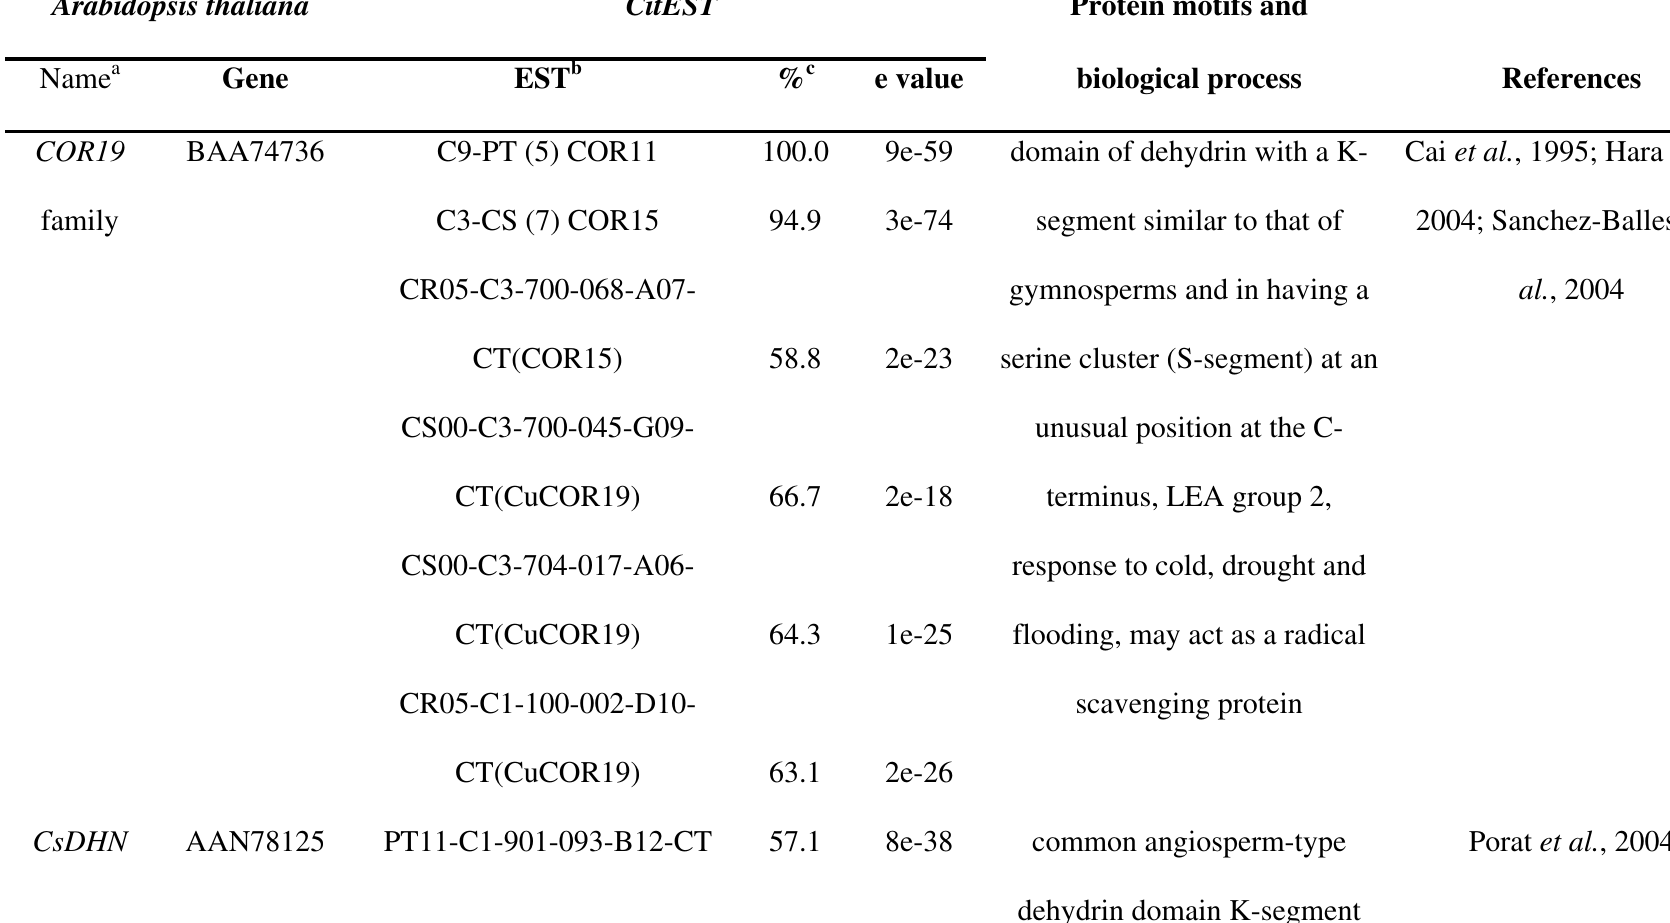
Table S5 – Citrus ESTs with homology to the late embryogenesis abundant proteins (LEA) gene family from Arabidopsis thaliana and other model